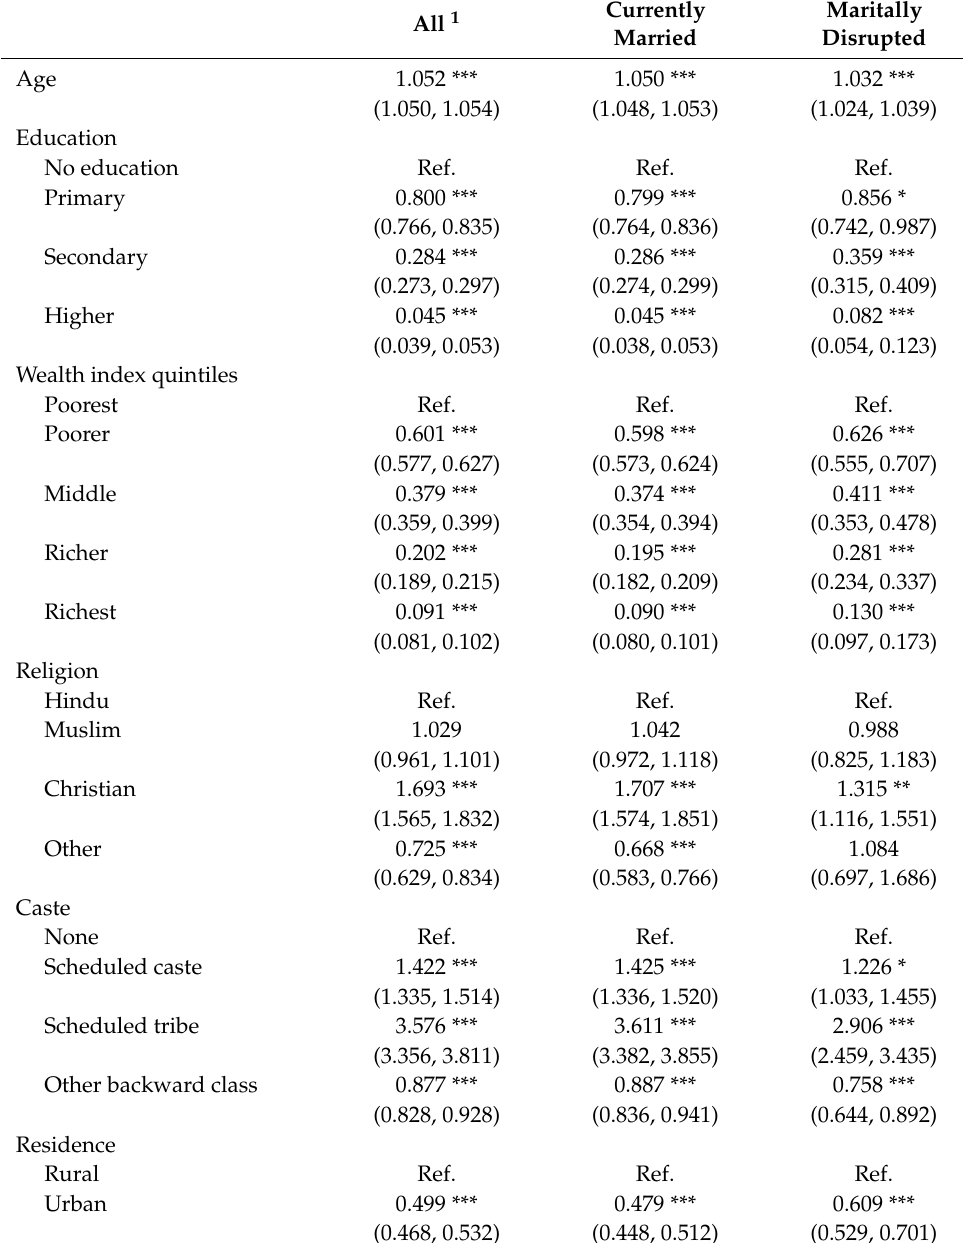
Table 3. Crude odds ratios in favor of tobacco use for the covariates by marital